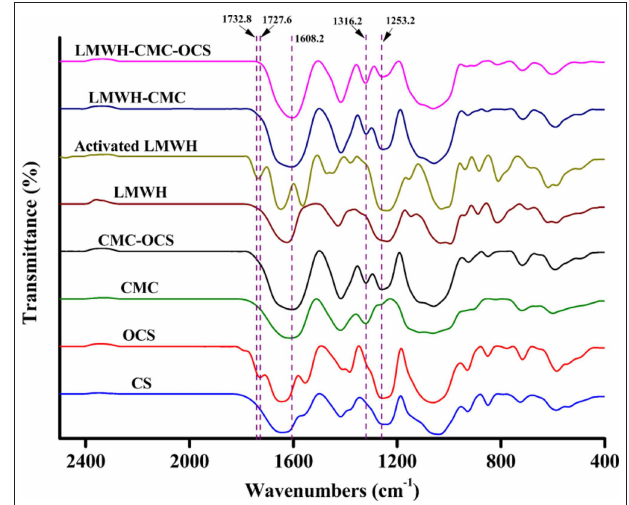
FIGURE 3 | FTIR spectra of polysaccharide derivatives (CS, OCS, CMC, LMWH, and EDC/NHS activated LMWH) and cross-linked CMC-OCS, LMWH-CMC, and LMWH-CMC-OCS